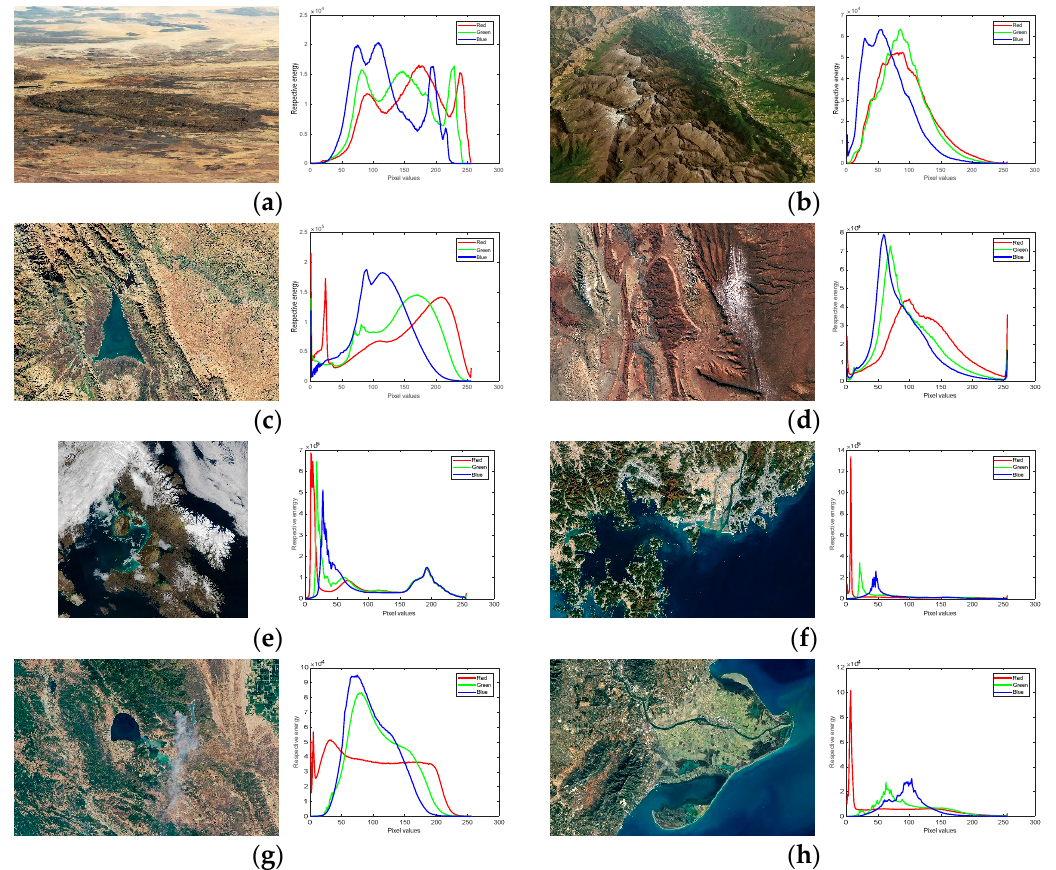
Figure 4. Original test images named ‘Image1’, ‘Image2’, ‘Image3’, ‘Image4’, ‘Image5’, ‘Image6’, ‘Image7’, and ‘Image8’, and the corresponding histograms for each of the color channels (red, green, and blue). ( a ) 1800 × 1200, ( b ) 2796 × 1864, ( c ) 5339 × 3559, ( d ) 2712 × 1808, ( e ) 4310 × 4019, ( f ) 2856 × 1904, ( g ) 3467 × 2311, ( h ) 1512 × 1008; ( left figure ) Original test images, ( right figure ) Histogram of each frame. Table 1. Average rank obtained by the proposed method (K = 12) under di ff erent parameter values. SF = 0.1 SF = 0.3 SF = 0.5 CR = 0.5 CR = 0.6 CR = 0.7 CR = 0.8 CR =